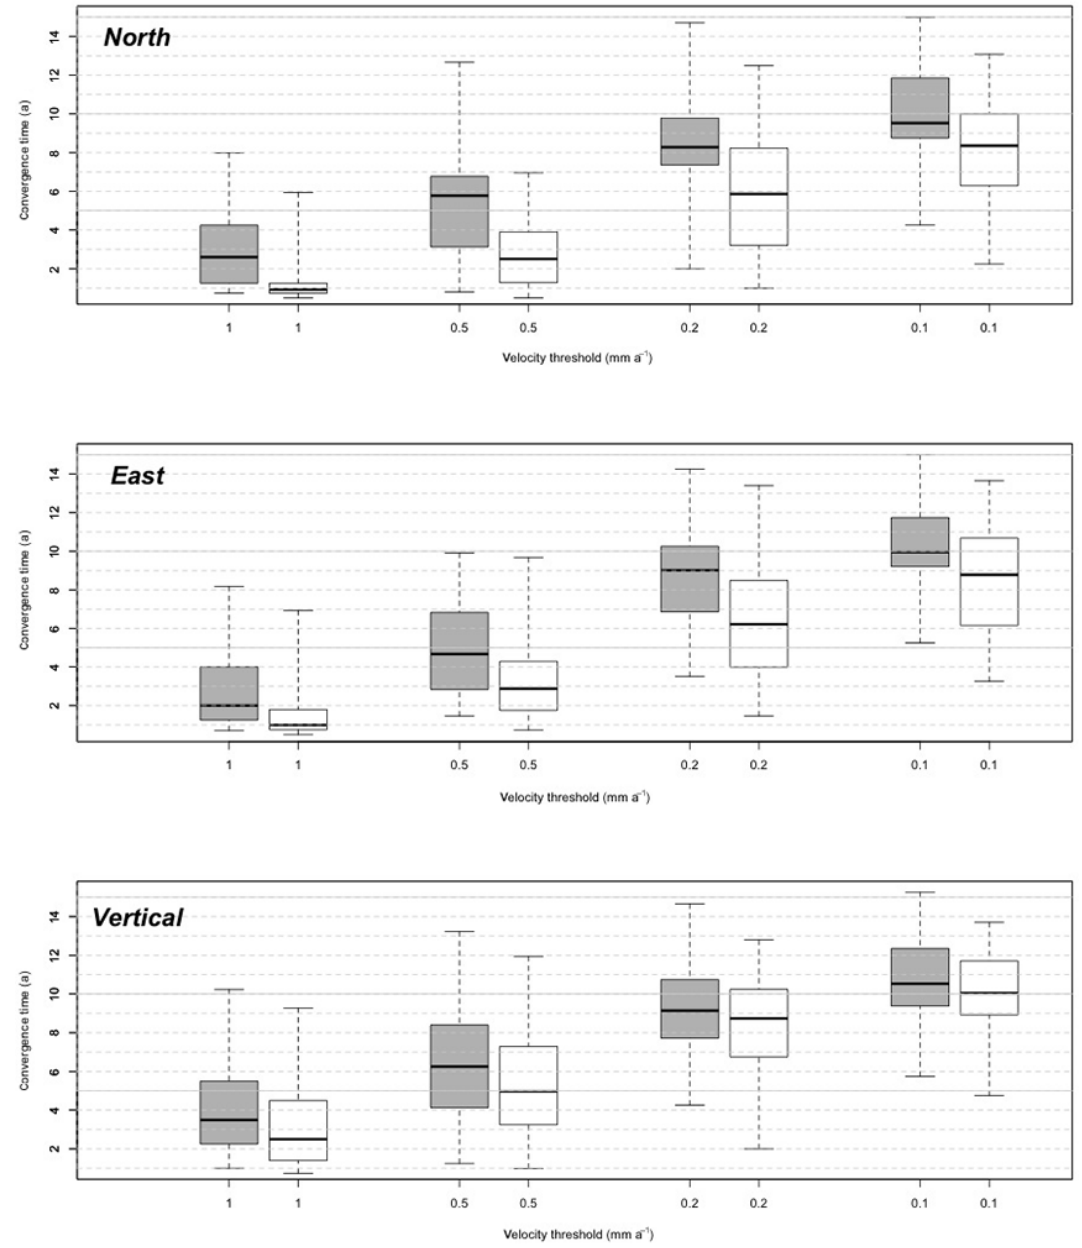
Figure 4. Whisker plots of convergence time for four velocity thresholds (1.0, 0.5, 0.2, and 0.1mmyr − 1 ). Thick bars, boxes, and dashed bars represent the median, quartile (25 and 75%) and extreme values of the distributions for the 44 stations with at least 10 years of data. Grey and white whisker plots correspond to unfiltered (raw) and filtered (with common-mode correction)